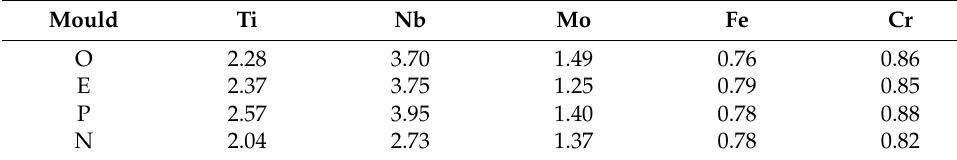
Table 3. Segregation ratio (SR) of alloying elements in the as-cast state.